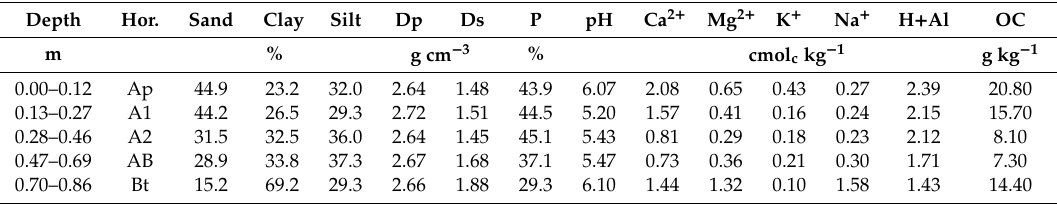
Table 1. Soil physical and chemical characteristics for the experimental plots. Alto Ipanema River Basin, Pernambuco State, Brazil. Source: [10,16]. Depth